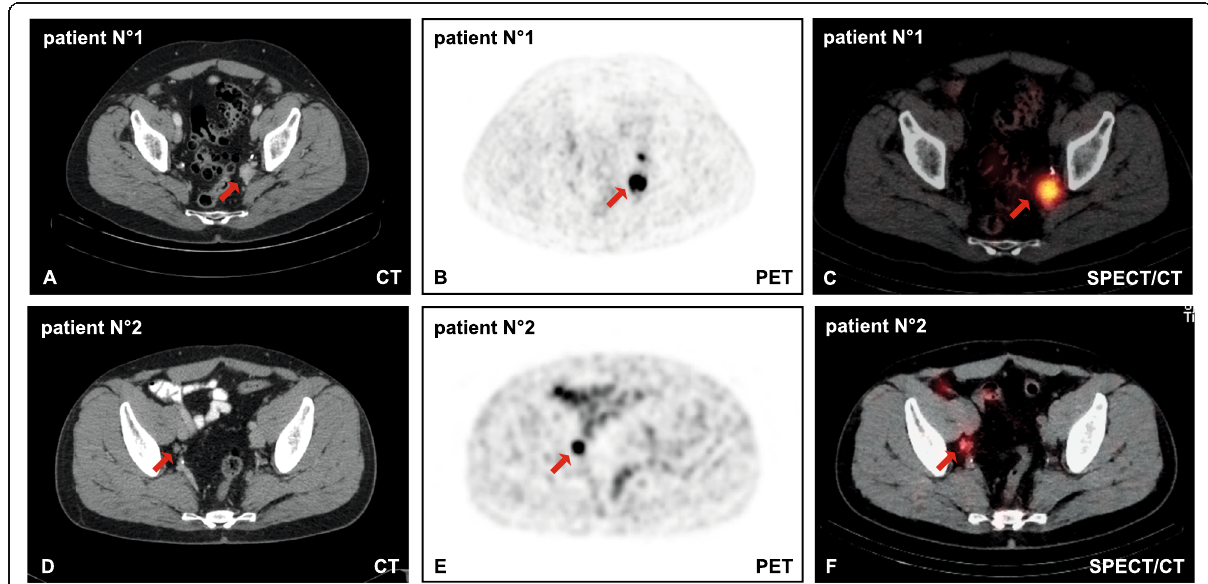
Fig. 1 a , d Transversal CT and b , e PET of a PSMA-PET/CT with from two different representative patients no. 1 and no. 2 with suspected lymph node metastases (LNM) prior to lymphadenectomy. c , f Preoperative (48 h preoperatively) transversal SPECT of the same patient. Suspected LNMs are indicated by a red